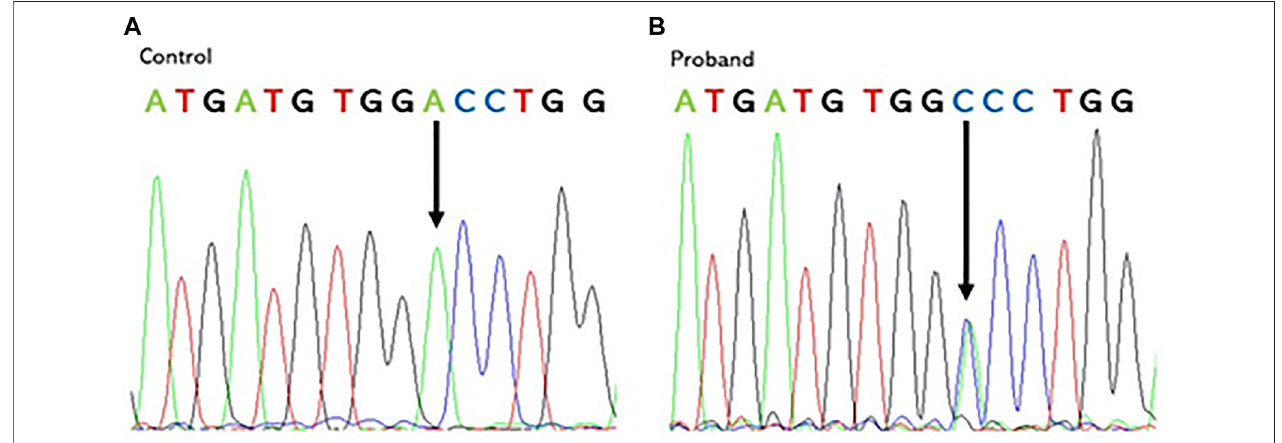
FIGURE 3 | Chromatogram of the control (A) and the proband (B) showing the heterozygous VCP mutation: a c.1184A > C nucleotide substitution in exon 10 at codon 395. Vertical arrows indicate the mutation site.